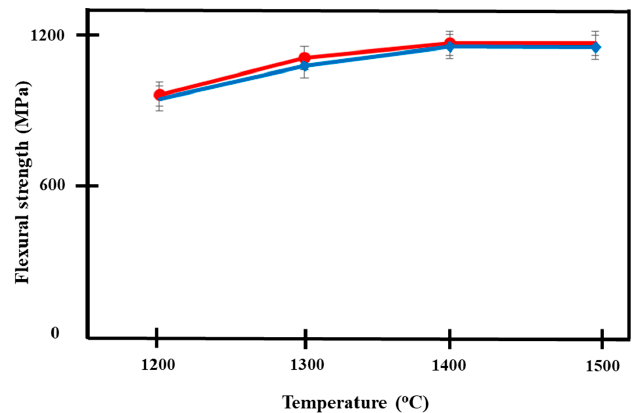
Figure 9. Flexural strength of Ca-SZ(CS); red line and Ca-SZ(CC); blue line when sintered for 2 h at different temperatures of 1200, 1300, 1400 and 1500 ° C.